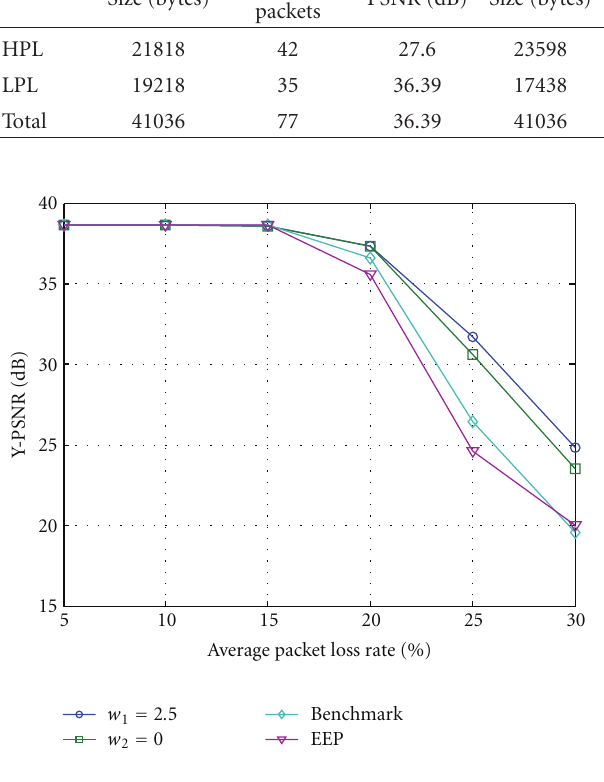
Figure 8: Optimized results for two values of w for the Foreman sequence. Figure 9: Optimized results for two values of